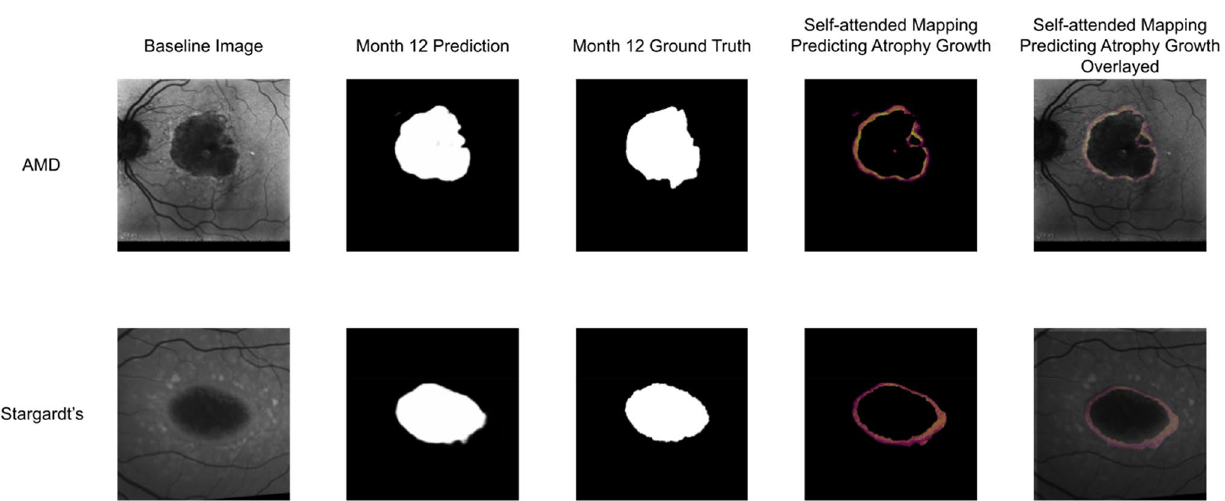
Figure 6. Illustration of the atrophy progression prediction results based on baseline images and Month 12 ground